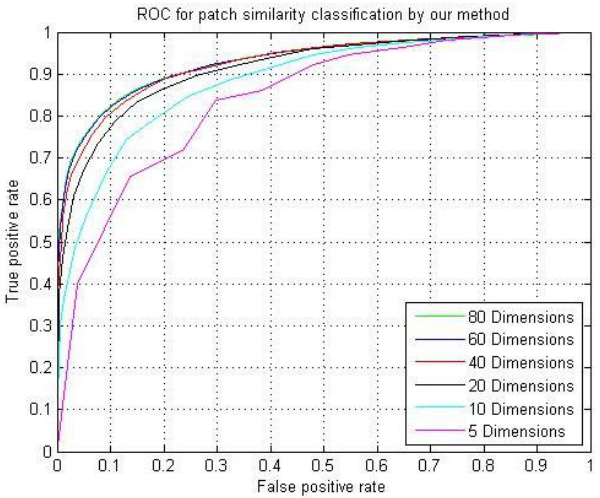
Fig. 4. ROC for descriptor learned at different dimensionality using 5000 similar + 5000 dissimilar samples